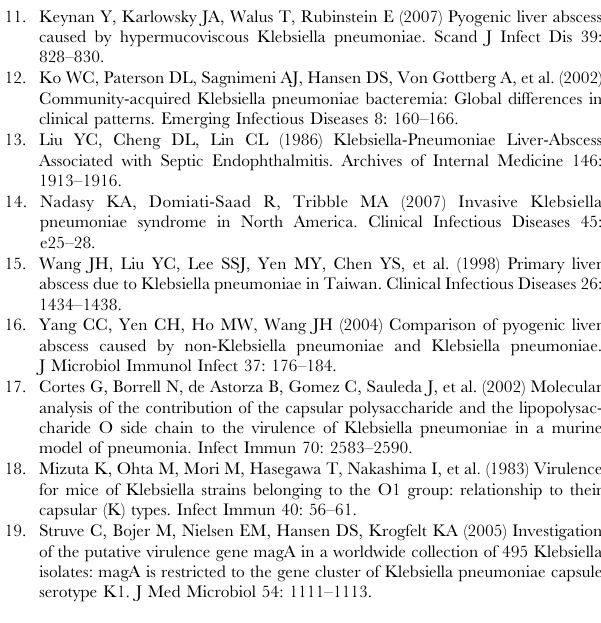
Table S1 PCR Primers used in this study. Table S2 Annotation and features of predicted ORFs in bacteriophage Ca0507-KN2